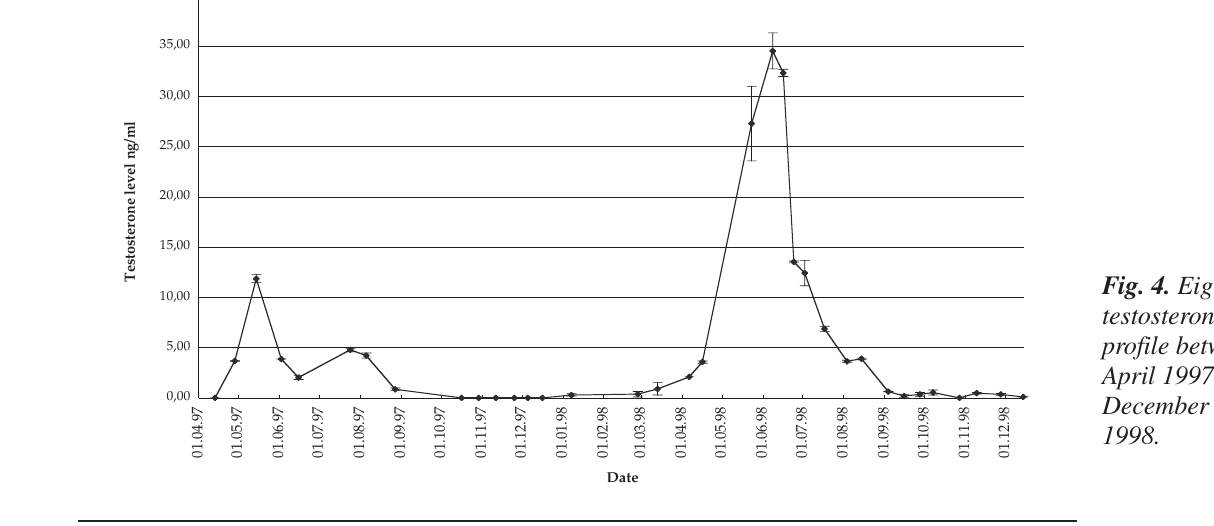
Fig. 4. Eigil's testosterone profile